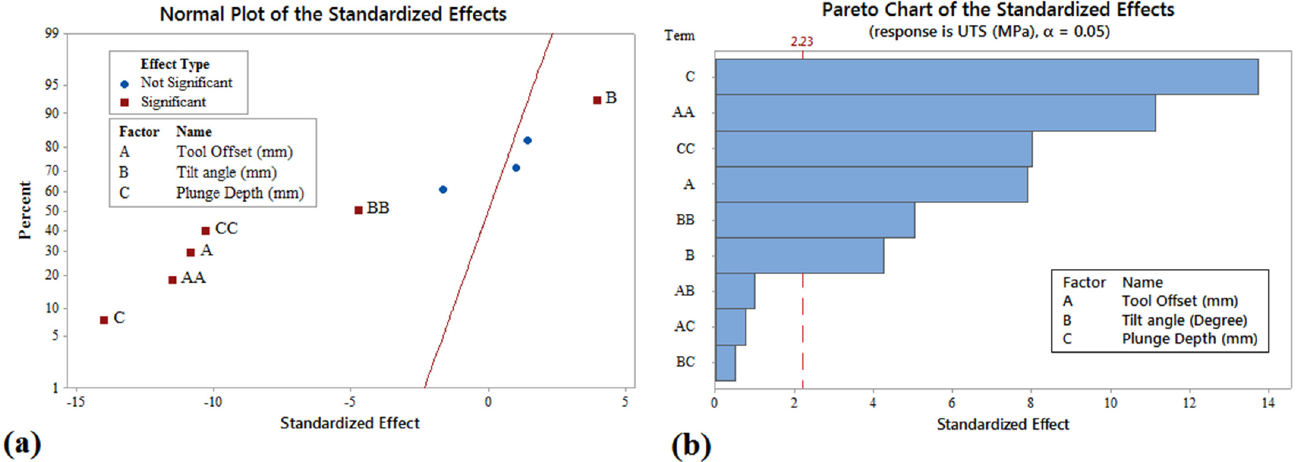
Figure 5. The effectiveness of model factors ( a ) Normal plot ( b ) Pareto plot.